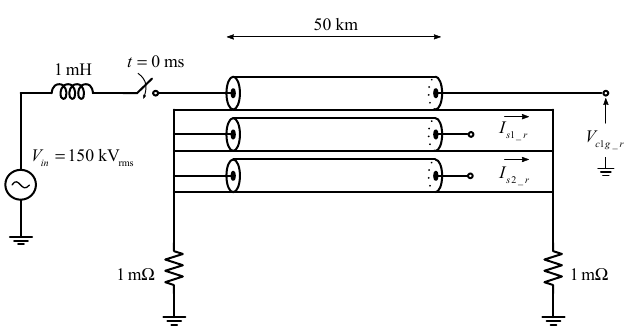
Figure 11. Setup for time response validation – Case Study #2.